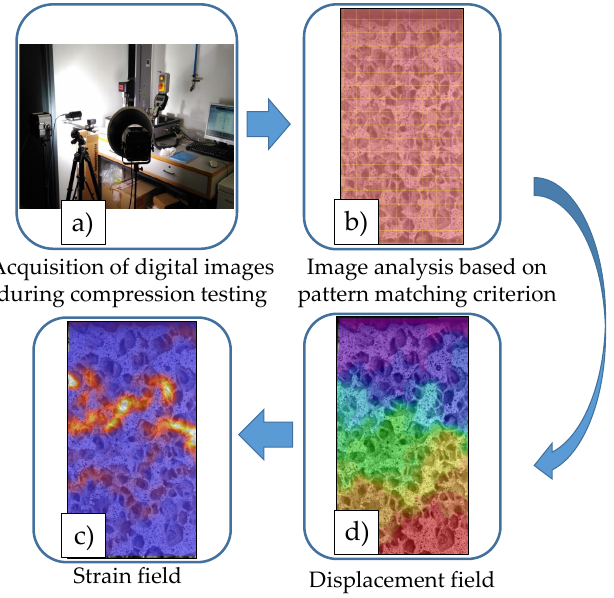
Figure 3. Scheme of digital image correlation (DIC) procedure. DIC is applied to ( a ) the images acquired during testing , which ( b ) are analyzed based on a pattern matching criterion, resulting in ( c ) the displacement field estimation. ( d ) The strain field is computed according to the chosen tensorial